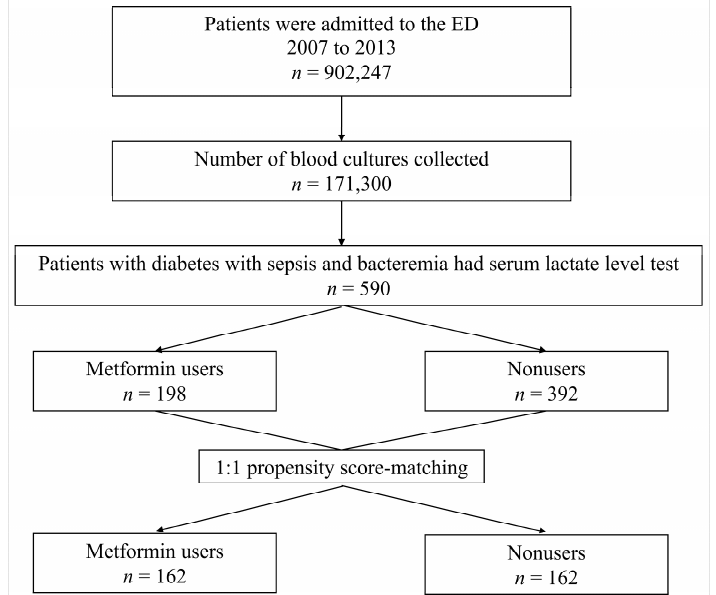
Figure 1. Flow diagram of the study design and analyses. ED: emergency department.